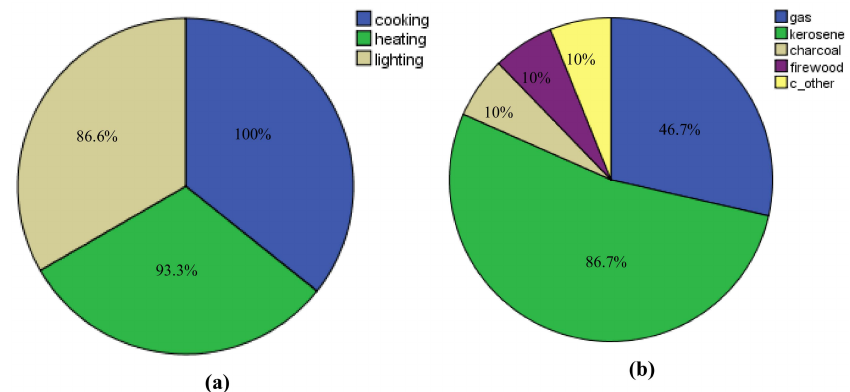
Figure 3. Distribution of energy ( a ) needs and ( b ) sources.